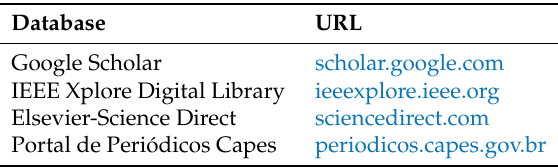
Table 2. Databases used in the